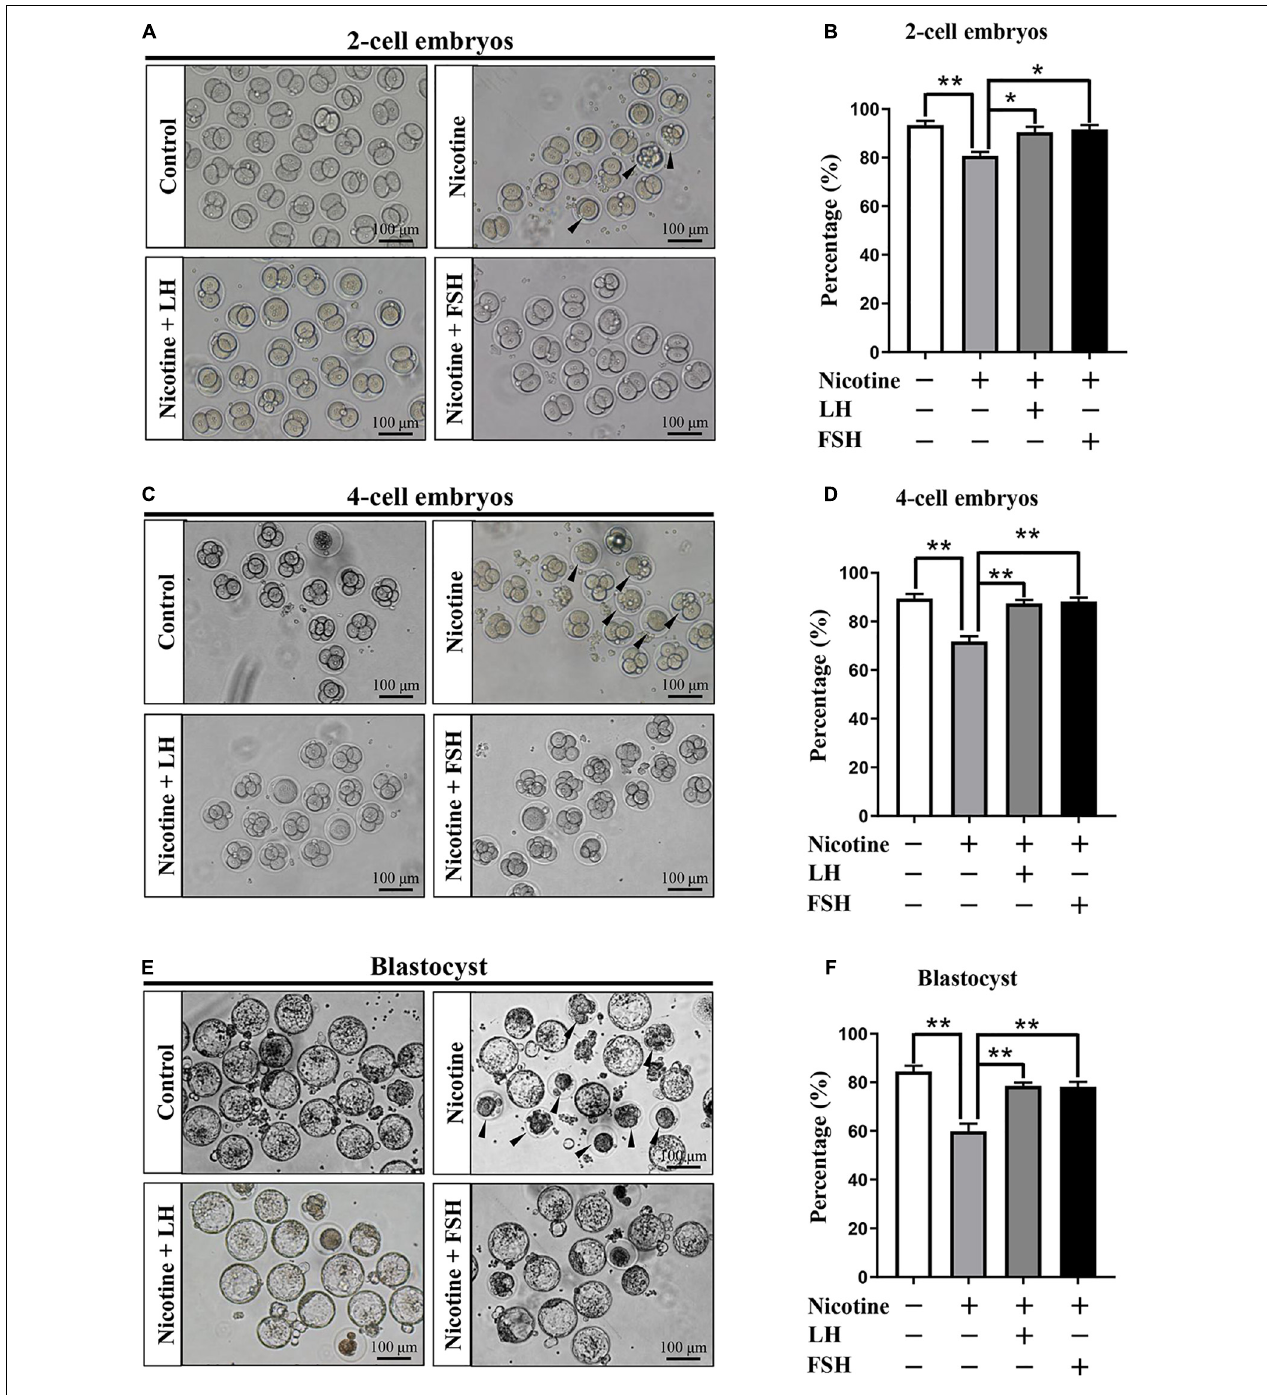
FIGURE 6 | Effects of LH or FSH on fertilization and early embryo development in nicotine-induced oocytes. (A) Representative images of two-cell embryos in each group. Scale bar, 100 µ m. The black arrows indicate two-cell embryos of developmental failure. (B) The rates of two-cell embryos in each group (control, n = 90; nicotine, n = 90; nicotine + LH, n = 90; and nicotine + FSH, n = 90; n = total number of oocytes from three replicate experiments). (C) Representative images of four-cell embryos in each group. Scale bar, 100 µ m. The black arrows indicate four-cell embryos of developmental failure. (D) The rates of four-cell embryos in each group (control, n = 90; nicotine, n = 90; nicotine + LH, n = 90; and nicotine + FSH, n = 90; n = total number of oocytes from three replicate experiments). (E) Representative images of blastocyst in each group. Scale bar, 100 µ m. The black arrows indicate blastocyst of developmental failure. (F) The rates of blastocyst in each group (control, n = 90; nicotine, n = 90; nicotine + LH, n = 90; and nicotine + FSH, n = 90; n = total number of oocytes from three replicate experiments; n = 16 newborn female pups in figure). The data are presented as means ± S.E. of three independent experiments (each in triplicate). * P < 0.05, ** P < 0.01.